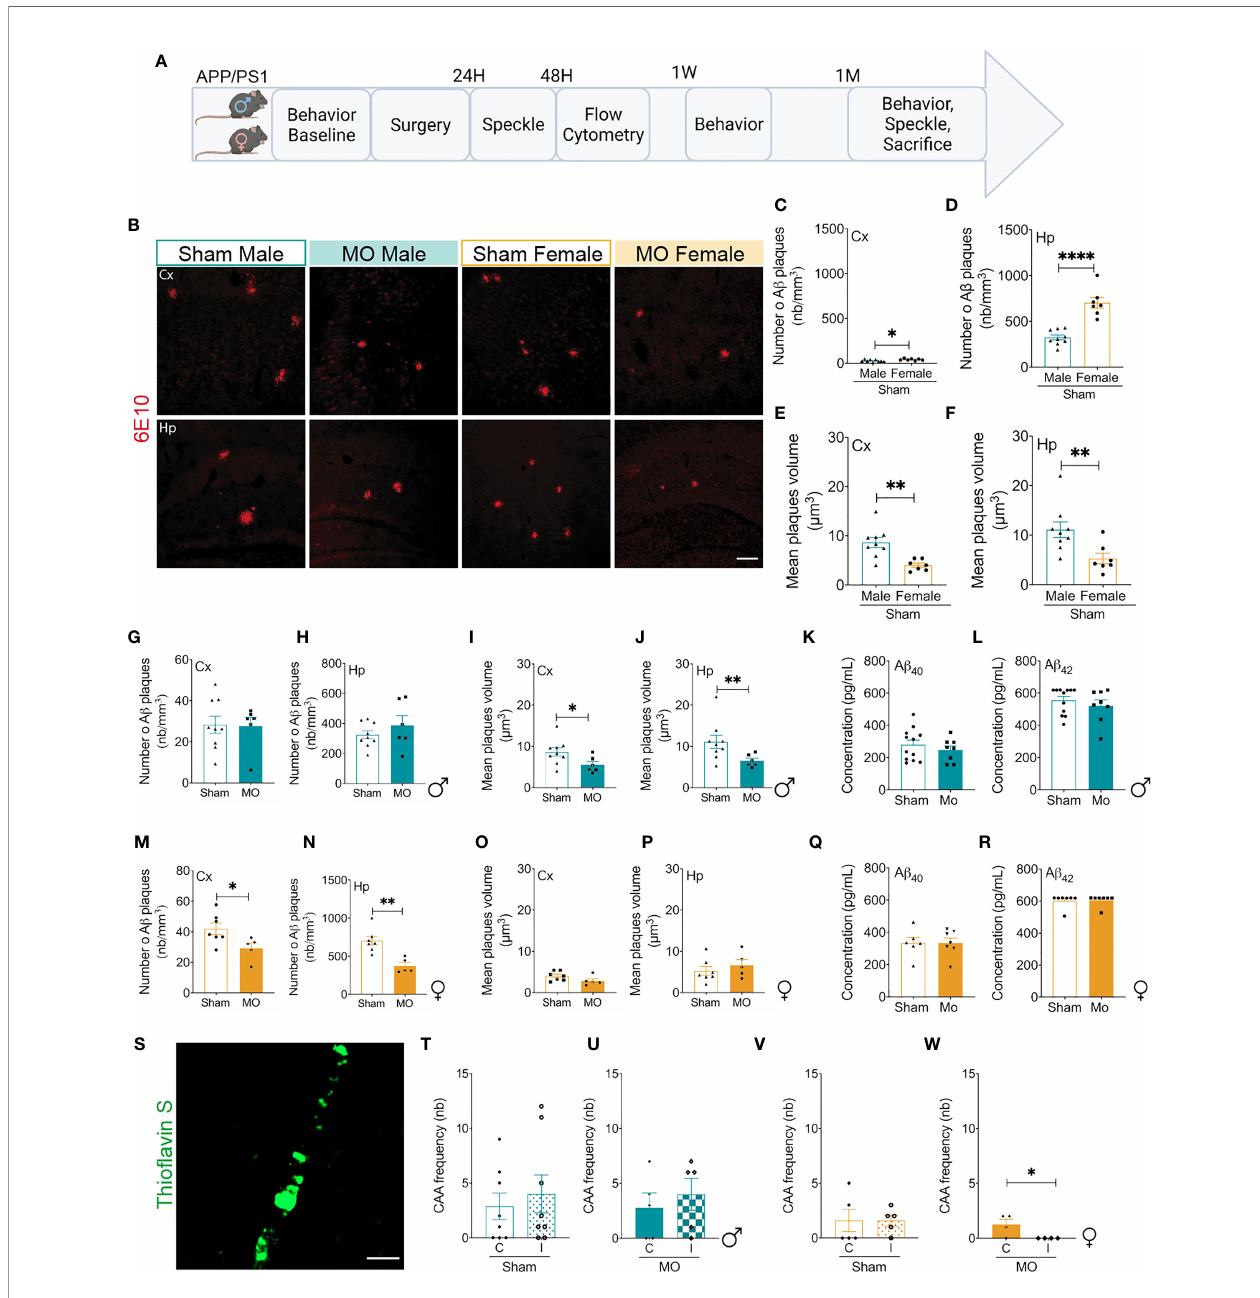
FIGURE 2 | Modulation of A b pathology in young APP/PS1 mice in response to microinfarcts. (A) A scheme illustrating the experimental design of our study. Created with BioRender.com. (B) Representative fl uorescent images of 6E10 immunolabeled A b plaques (red) in the cortex and hippocampus of sham- and MO-operated male and female APP/PS1 mice. Immuno fl uorescence combined to stereological analysis shows that sham-operated female APP/PS1 mice exhibit a higher number of A b plaques in the (C) cortex and (D) hippocampus compared to sham-operated males, while sham-operated male APP/PS1 mice develop A b plaque of higher volume compared to sham-operated females in the (E) cortex and hippocampus (F) . Moreover, immuno fl uorescence combined to stereological analysis indicates that the number of A b plaques in the (G) cortex and (H) hippocampus of MO-operated male APP/PS1 mice remains unchanged, but the volume of A b plaques decreased in MO-operated mice in the cortex (I) and hippocampus (J) . ELISA analysis shows that the levels of soluble (K) A b 40 and (L) A b 42 in the brain of male APP/PS1 mice remain unchanged. Immuno fl uorescence combined to stereological analysis shows that the number of A b plaques decreases in the (M) cortex and (N) hippocampus of MO-operated female APP/PS1 mice compared to sham-operated animals, whereas the volume of A b plaques remains unchanged in both structures (O, P) . ELISA analysis indicates that the levels of soluble (Q) A b 40 and (R) A b 42 remain as well unchanged in the brain of MO-operated female APP/PS1 mice. Histological analysis of Thio fl avin labeling (S) shows that the frequency of CAA (Thio fl avin S + ; green) remains unchanged in the ipsilateral hemisphere of (T) sham-operated APP/P1 mice and (U) MO-operated APP/PS1 mice compared to the contralateral hemisphere, whereas it remains unchanged in the brain of (V) sham-operated female APP/PS1 mice, and (W) decreases in the ipsilateral hemisphere of MO-operated female APP/PS1 mice. Data are mean ± SEM (n = 5-10 animals/group). *P < 0.05/**P < 0.01/****P < 0.0001 compared to sham-operated WT or APP/PS1 mice (two-tailed unpaired t-test). Scale bar = 250 µm (B) and 500 µm (S)